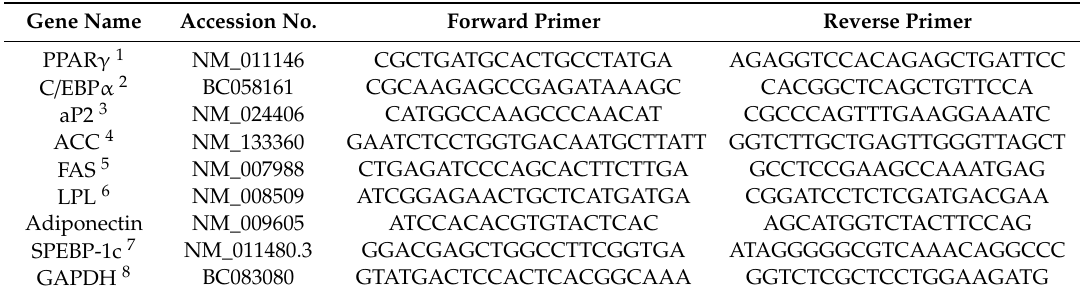
Table 1. Description of target genes and their primer sequences used for real-time polymerase chain reaction